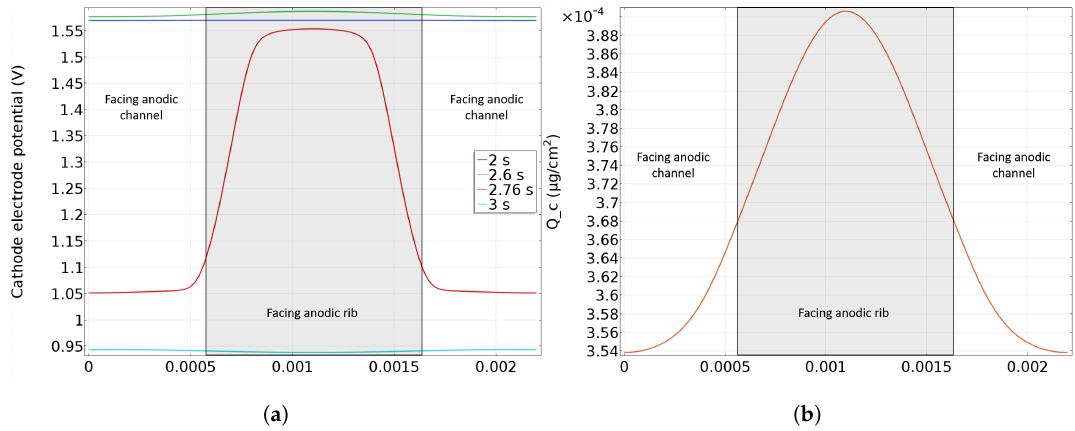
Figure 6. In plane cathode electrode potential ( a ) and resulting carbon loss ( b ) along the CCL at the cathode